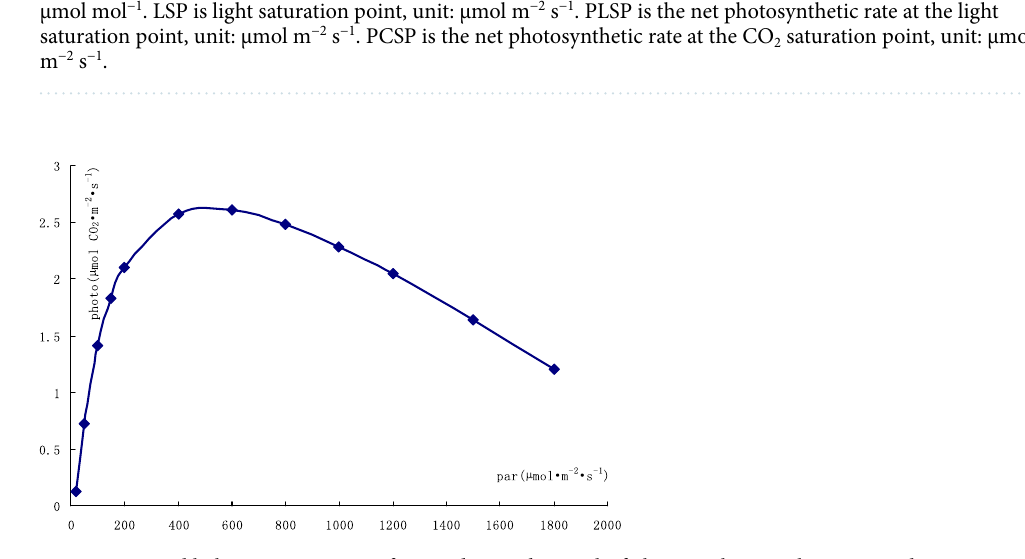
Figure 2. Fitted light response curve of Epimedium pubescens leaf photosynthesis with average